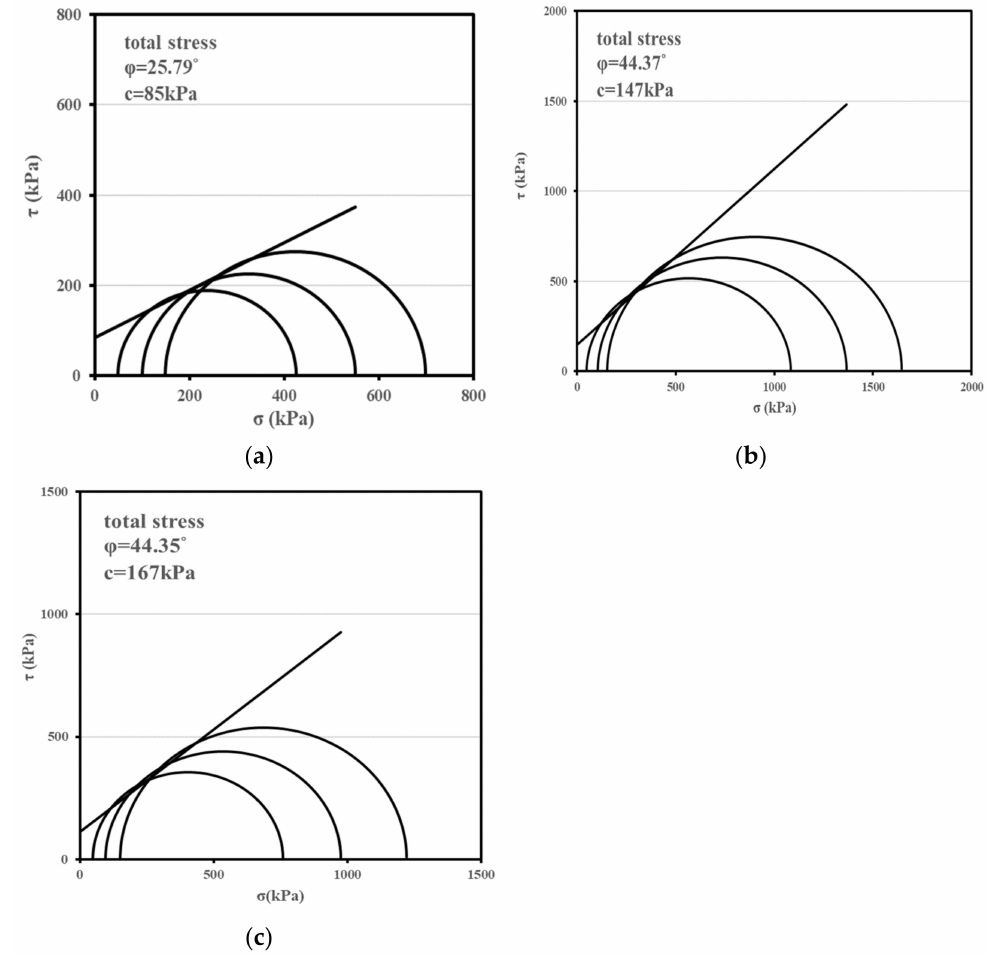
Figure 12. Mohr circle and shear strength parameters of the testing samples for triaxial Consolidated Undrained tests: ( a ) CU-0%; ( b ) CU-4%; ( c ) CU-8%.